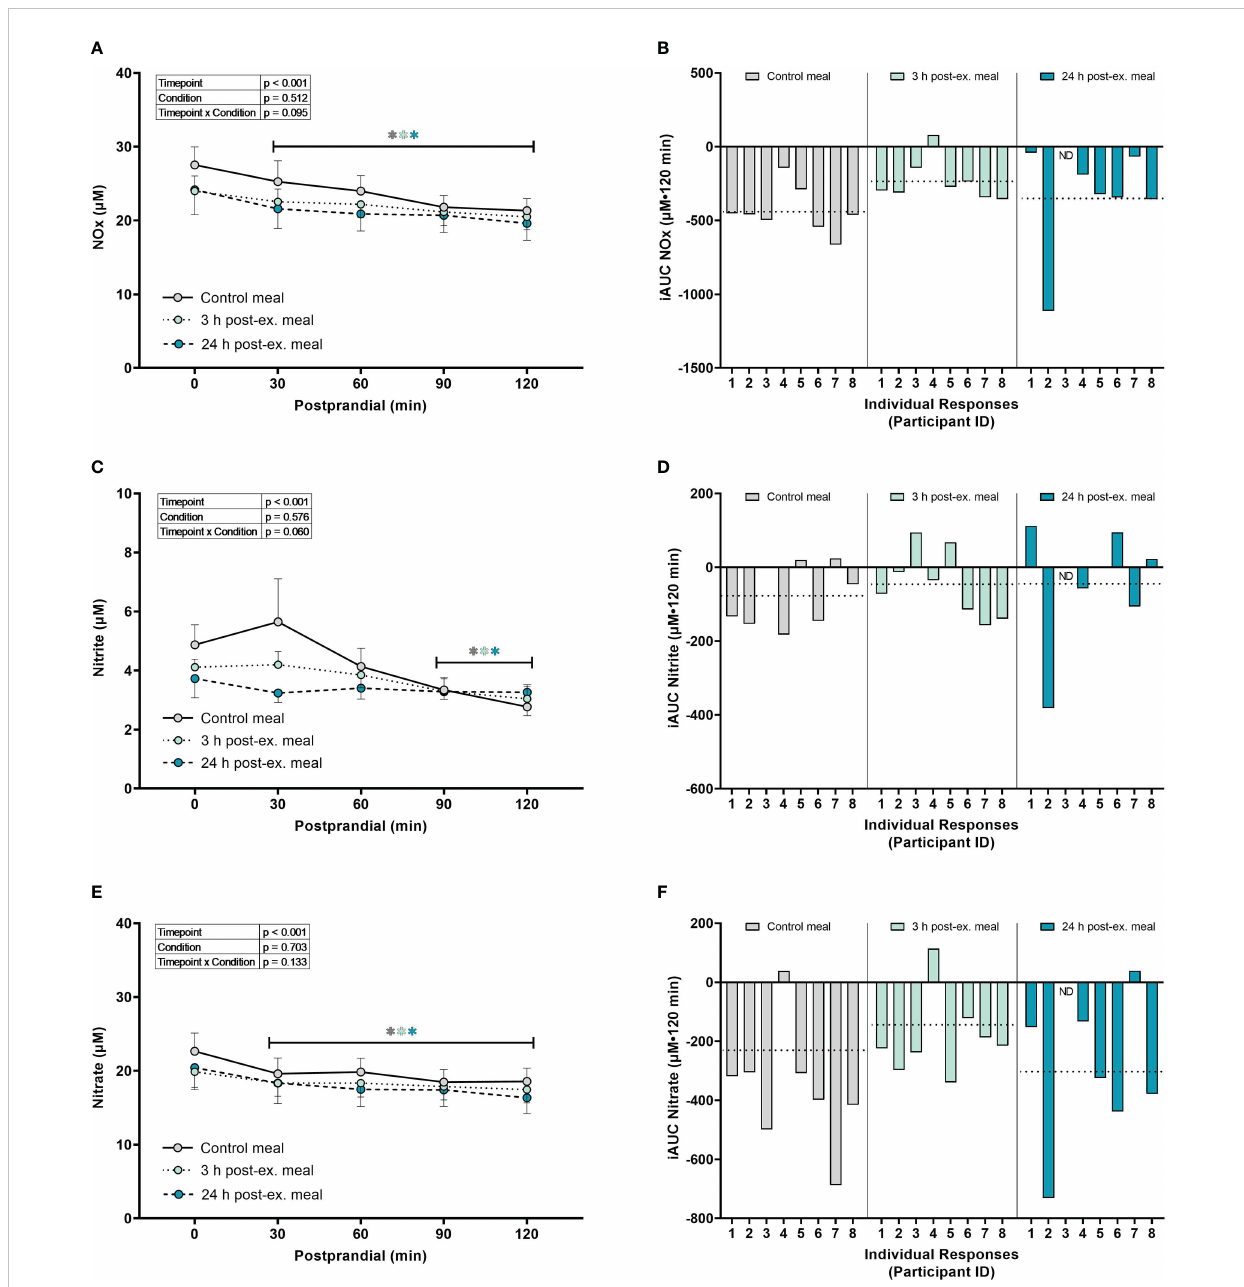
FIGURE 6 The effects of a high-glucose mixed nutrient meal on serum Nitrate+Nitrite (NOx) (A, B) , Nitrite (C, D) , and Nitrate (E, F) , when ingested at rest (no- exercise control meal), and 3 h and 24 h post-exercise. Line graphs (A, C, E) are presented as mean ± SEM. Individual responses (B, D, F) are presented as the incremental area under the curves (iAUC) following meal ingestion at rest (control meal), and 3 h and 24 h post-exercise. The dotted line represents the group average iAUC value. Postprandial data (line graphs) were analyzed using a mixed-effects model with “ time ” (pre- meal and postprandial timepoints) and “ condition ” (control meal, 3 h post-exercise meal, and 24 h post-exercise meal) as the within-subjects factors. Fishers LSD test was used for multiple comparisons. *p < 0.05 compared to pre-meal levels (0-min). n = 8 participants for control and 3